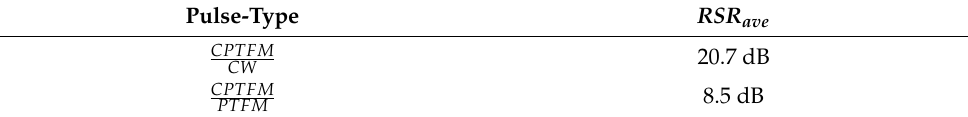
Table 2. Theoretical average RSR gain of the CPTFM over the CW and PTFM